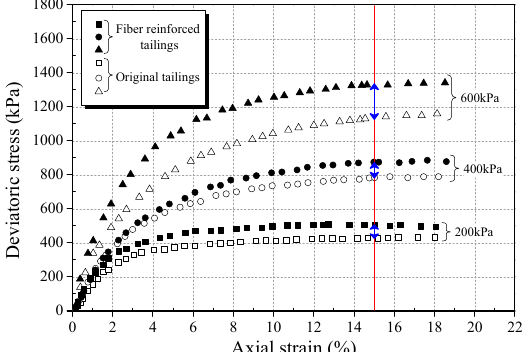
Figure 14. Stress strain curve for unreinforced and reinforced tailings silt (0.4 wt% fiber content).